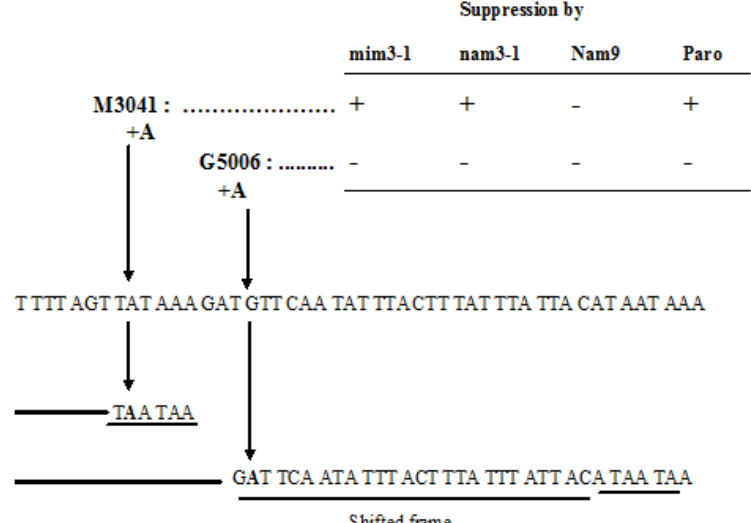
FIGURE 1: Nucleotide sequence of suppressed and non-suppressed frameshift mutations in the RNA-maturase coding part of the second intron of the cytochrome b gene. Note that both mutations create double ochre stop co- dons, one immediately after the addition of adenine (M3041) and the other after a shift of nine amino acids after the addition of adenine (G5006). Numbering like in table 1.